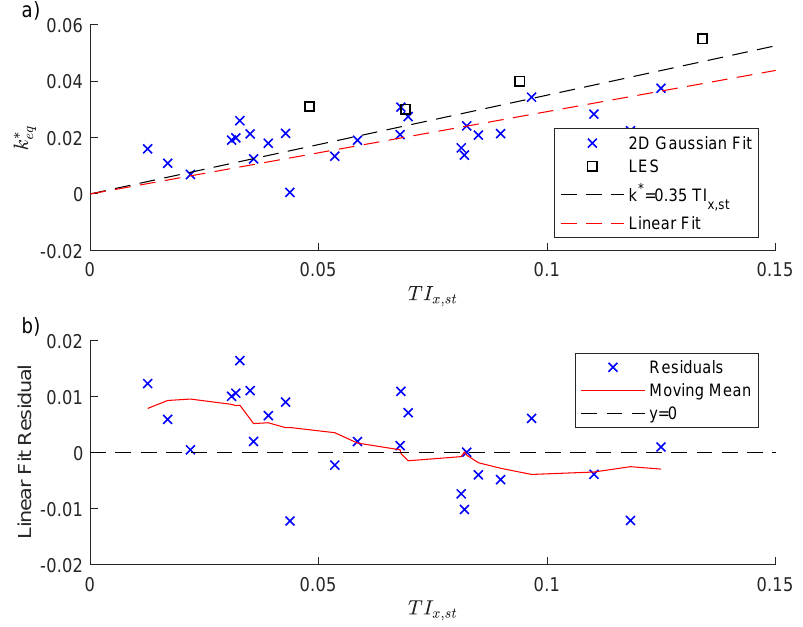
Figure 5. The upper panel ( a ) shows the (equivalent) wake growth rate k ∗ eq as a function of the streamwise turbulence intensity TI x , st . The blue crosses show results from the volumetric measurements and the red dashed line a linear fit with k ∗ eq = 0.30 TI x , st . The black dashed line shows the result from planar wakes scans during the same experiment presented by Fuertes et al. [26] and the black squares show the results of large-eddy simulations by Wu and Porté-Agel [34]. The lower panel ( b ) shows the residuals of the linear fit (blue crosses) as a function of the turbulence intensity together with a moving mean spanning 7 data points (red